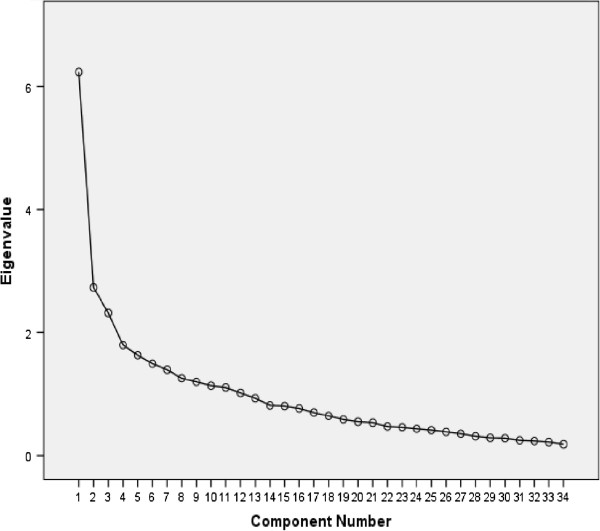
34-item MLCDP scree plot showing the amount of variance (see Appendix).